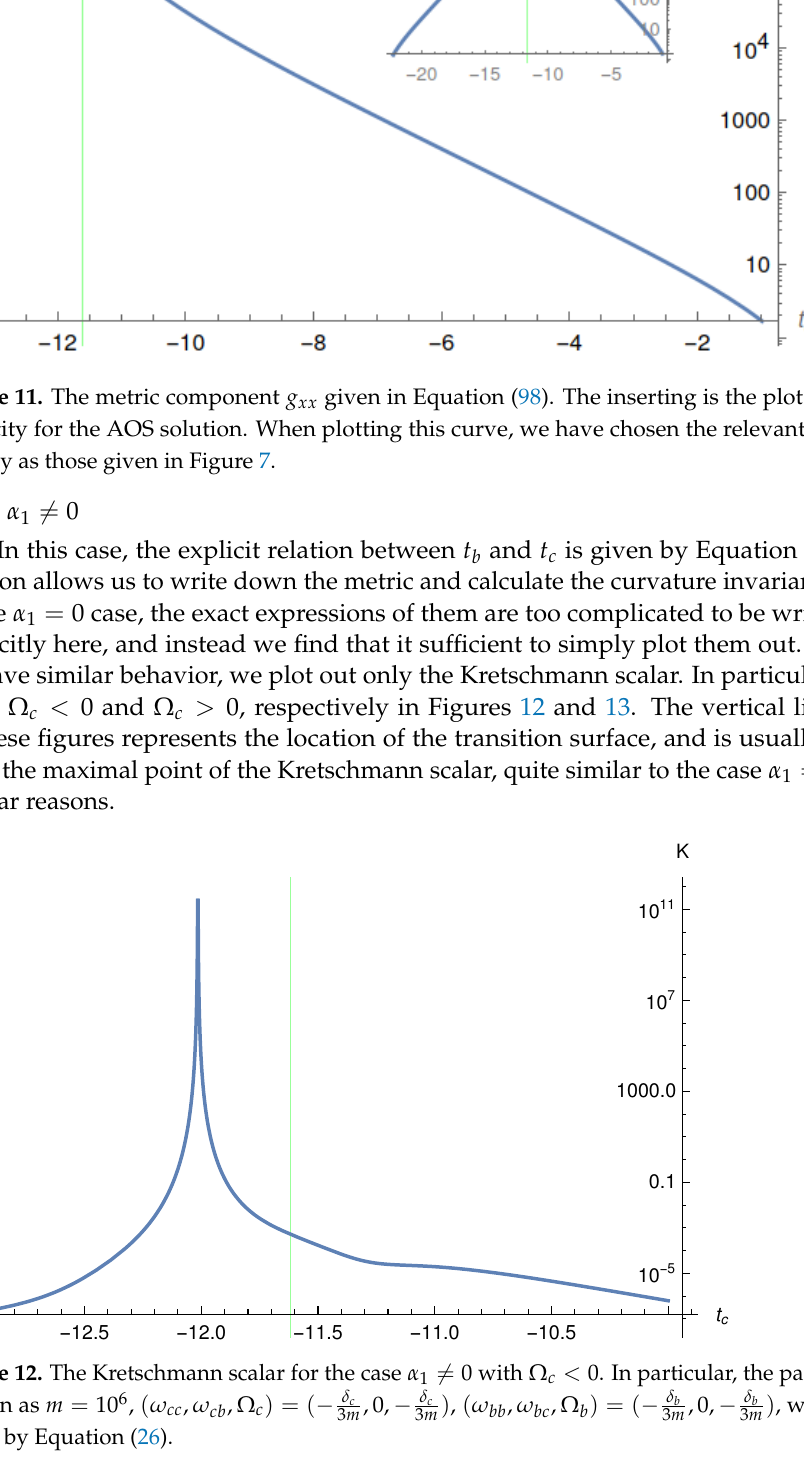
Ω ) , ( ω ) = ( − δ b ) , where δ ,0, − δ c ,0, − δ b i ’s are bb , ω bc , b 3 m 3 m 3 m 3 m